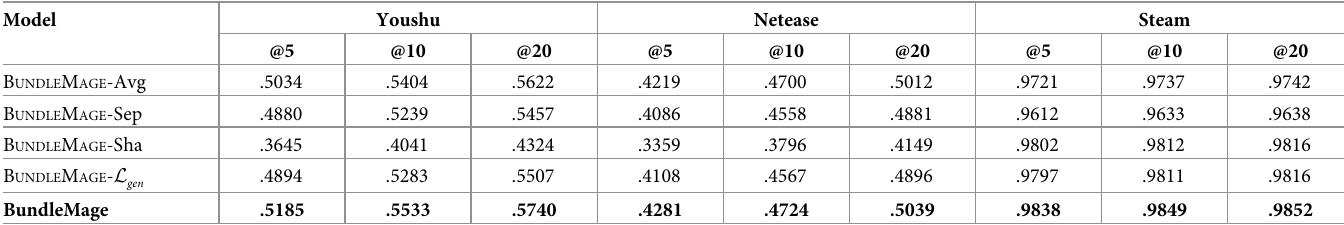
Table 5. Evaluation of BundleMage and its variants for bundle matching with respect to nDCG.